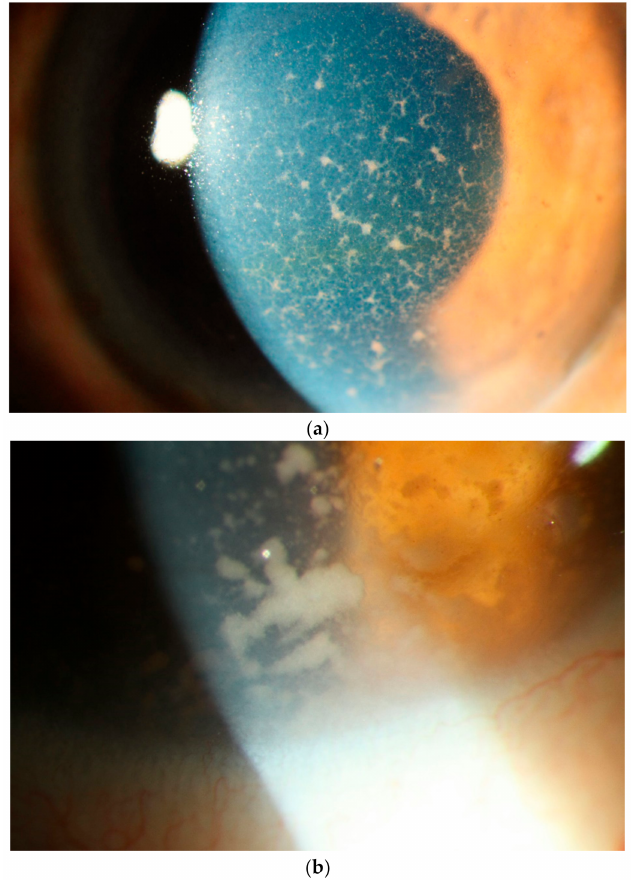
Figure 7. Slit lamp photograph showing ( a ) diffusely distributed keratic precipitates (KP) on the corneal endothelium. These KPs are a mixture of small and fine or infiltrative KP intermixed with some granulomatous KP. Many of these granulomatous KP have fibrillar extensions, taking on a comet-like appearance, typical of vitreoretinal lymphoma. These faintly pigmented KP may be mistaken for the KP of viral anterior uveitis. ( b ) Occasionally one can find even larger tumor cell collections on the